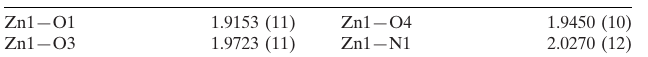
Selected bond lengths (A˚ ).